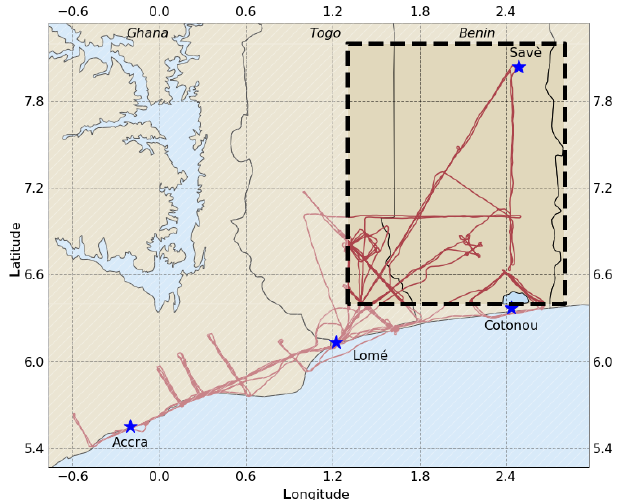
Figure 1. Map of the Twin Otter flight paths. The box represents locations where data was used in this analysis to compare with ra- diosonde data from the Savè supersite.